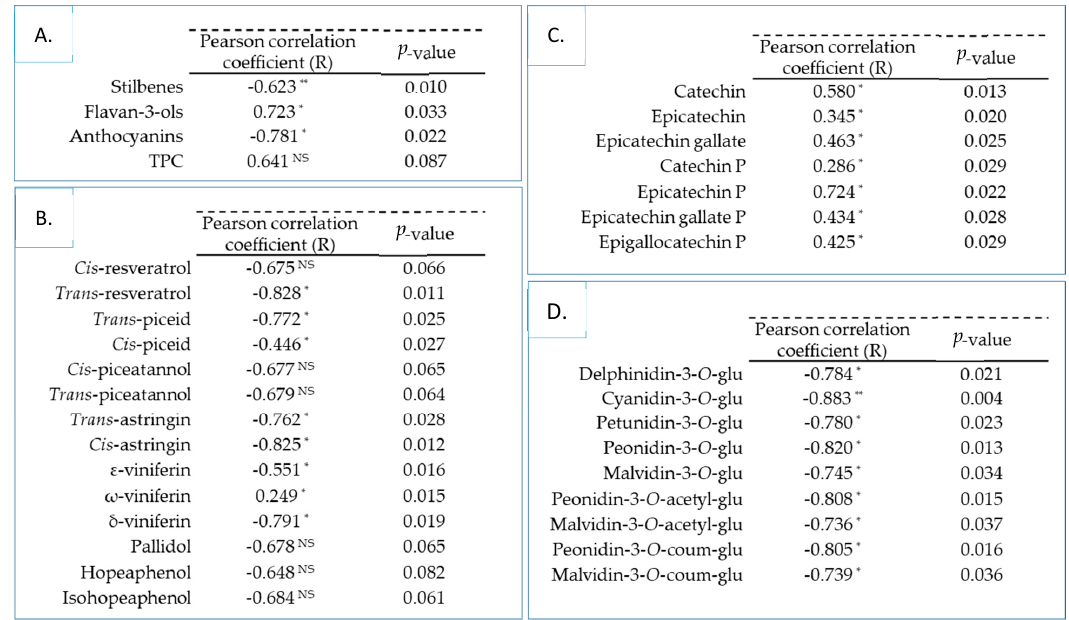
Figure 4. Pearson’s correlation coefficient (with α = 0.05) between α -glucosidase inhibitory activity of all skin and seed Tannat grape extracts and total polyphenol families ( A ), stilbene ( B ), flavan-3-ol ( C ) and anthocyanin ( D ) compounds.